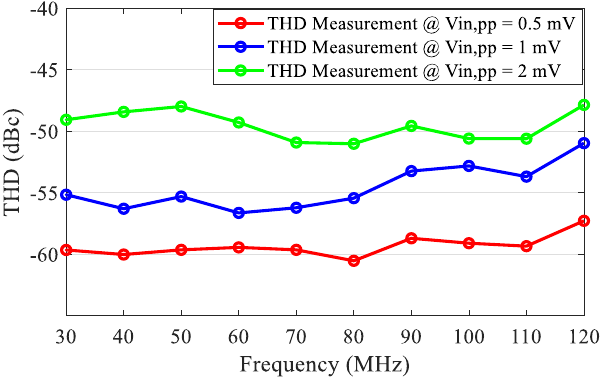
Figure 20. The measured THD of the front-end.